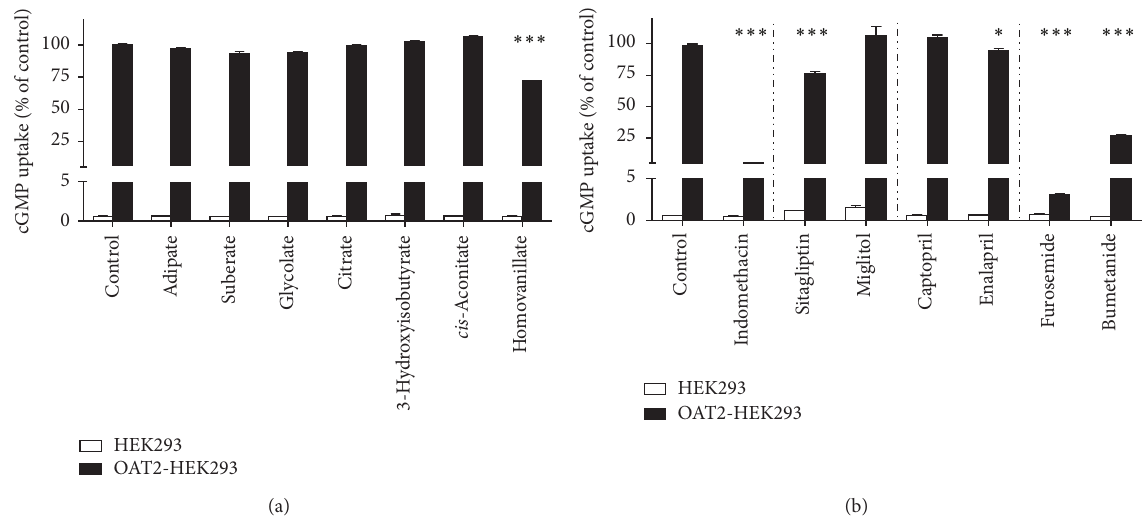
Figure 3: Influence of dicarboxylates, metabolites, and drugs on OAT2-mediated cGMP uptake in HEK293 cells. The uptake of cGMP was determined after 5 min incubation with 10 𝜇 M cGMP (0.1 𝜇 M [ 3 H ] cGMP + 9.9 𝜇 M unlabeled cGMP) alone (controls) or in the presence of 500 𝜇 M potential inhibitors at 37 ∘ C. (a) Dicarboxylates and metabolites; (b) drugs. Data are presented as mean ± SEM. 𝑛 = 3 . ∗ 𝑃 < 0.05 ; ∗∗∗ 𝑃 < 0.001 , compared to